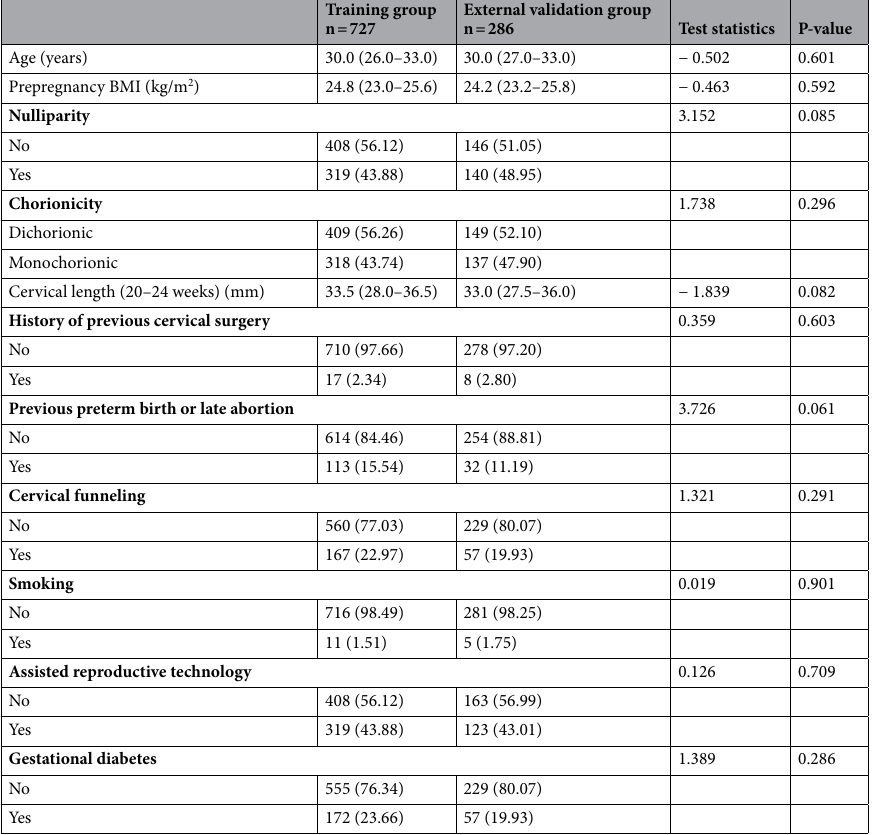
Table 1. Characteristics of Twin pregnant women in training and validation group. Data are shown as number (%) or median (IQR). BMI body mass